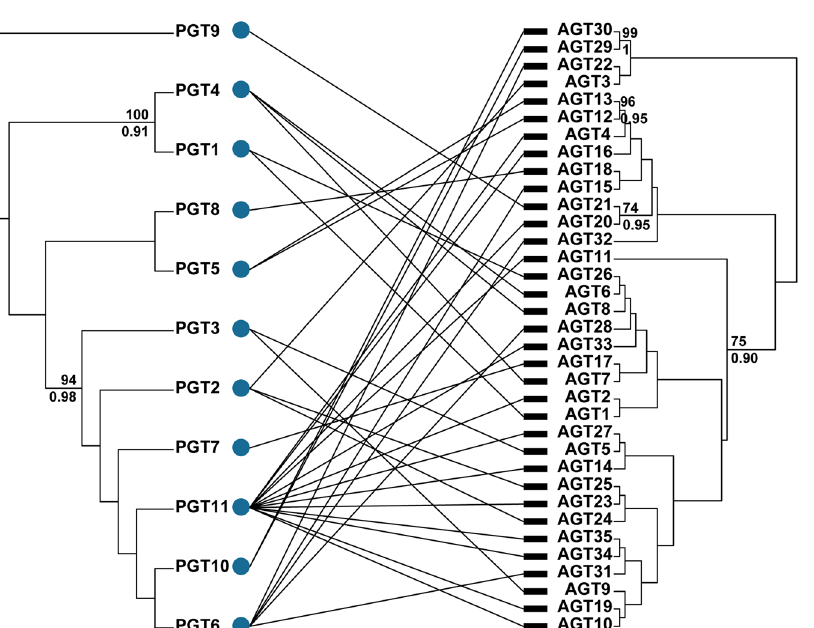
Figure 3. Network of P. umbellatus - Armillaria interactions. Lines represent pairwise interactions. Maximum clade credibility trees from Bayesian relaxed clock analyses are shown for P. umbellatus and Armillaria isolates. Branch support values above the branches show maximum likelihood nonparametric bootstrap percentages. Support values below branches are posterior probabilities. PGT, P. umbellatus genotype; AGT, Armillaria